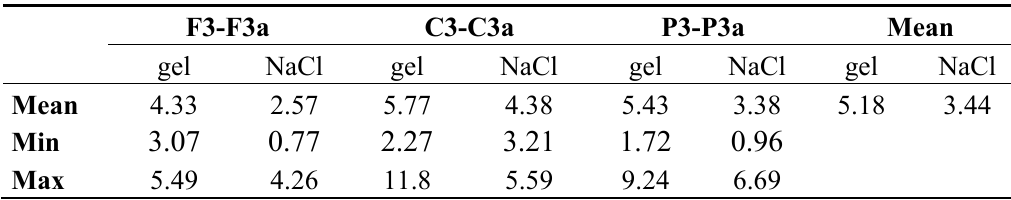
Table 4. RMS error (microvolt) in the time domain between the three pairs of textile electrode Type I and standard electrodes using gel and NaCl, respectively (standard electrodes are denoted with an “a” after the channel name). To the right the grand average is given.